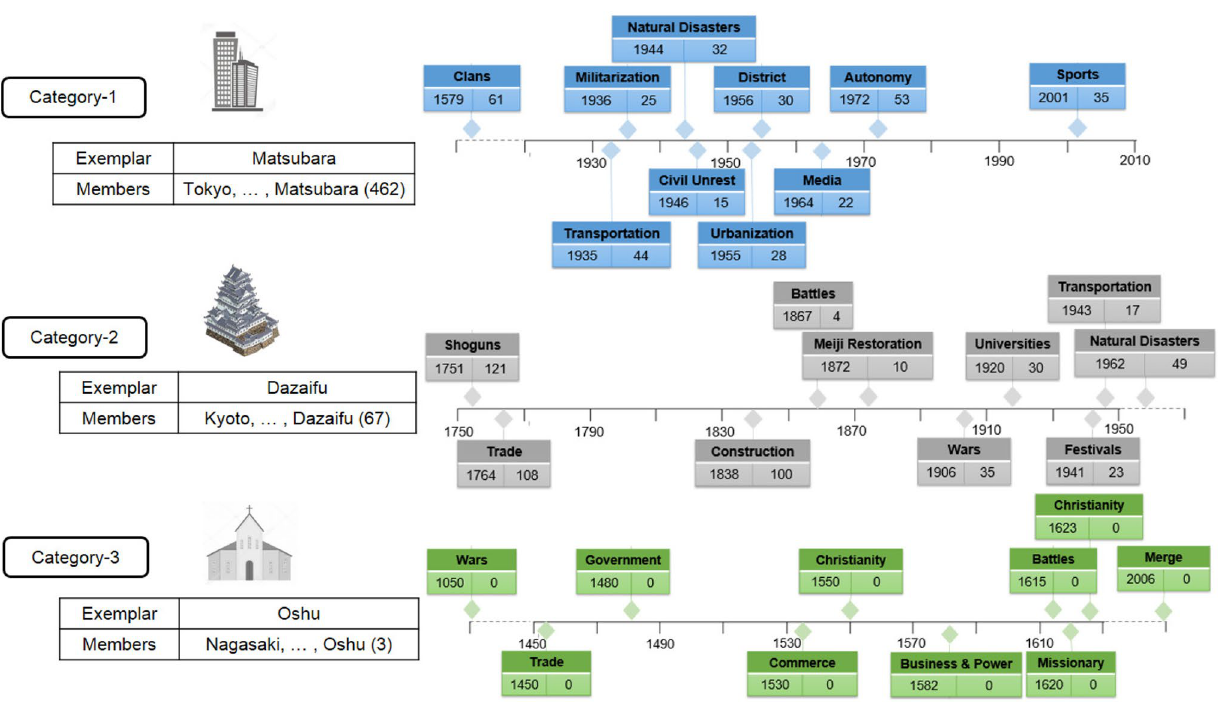
Fig. 1 Typical histories of three latent history-based categories of Japanese cities which were learned from 532 instances using our pro- posed system. Each category is represented in two ways: by a typical instance city (which we call an exemplar), as well as by a timeline consisting of major events ordered chronologically by their computed median occurrence time (which we call a prototype). Each event clus-